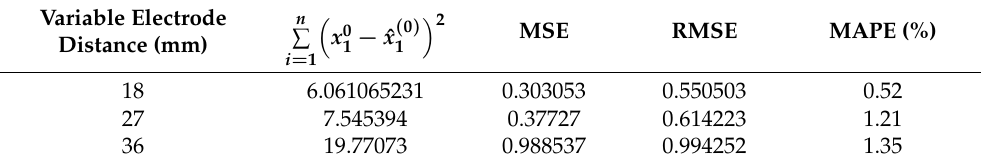
Table 6. Root mean square error (RMSE) for actual and prediction